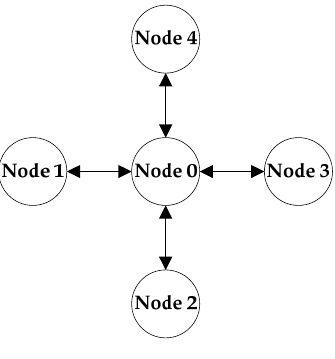
Figure 3. Topology of Nodes in the Network.